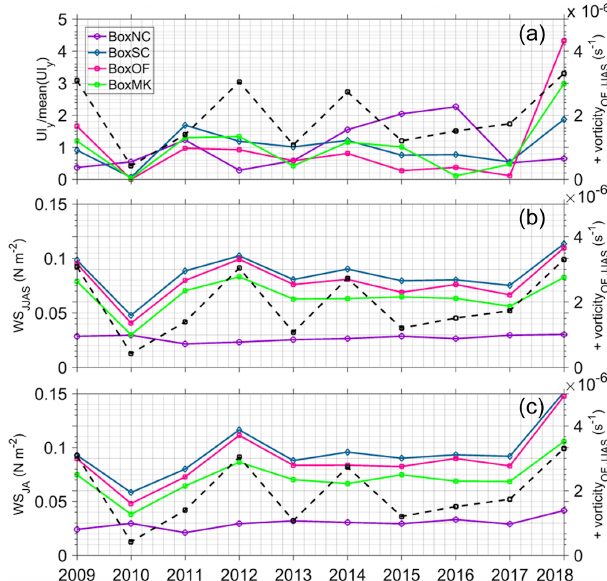
Figure 13. Interannual time series of normalized yearly upwelling index (first row), average JJAS (second row), and JA (third row) wind stress (Nm − 2 ) over each upwelling box (BoxNC: purple; BoxSC: blue; BoxOF: pink; BoxMK: green). The black dashed curve shows the integrated positive summer surface current vortic- ity over BoxOF (s − 1 ).